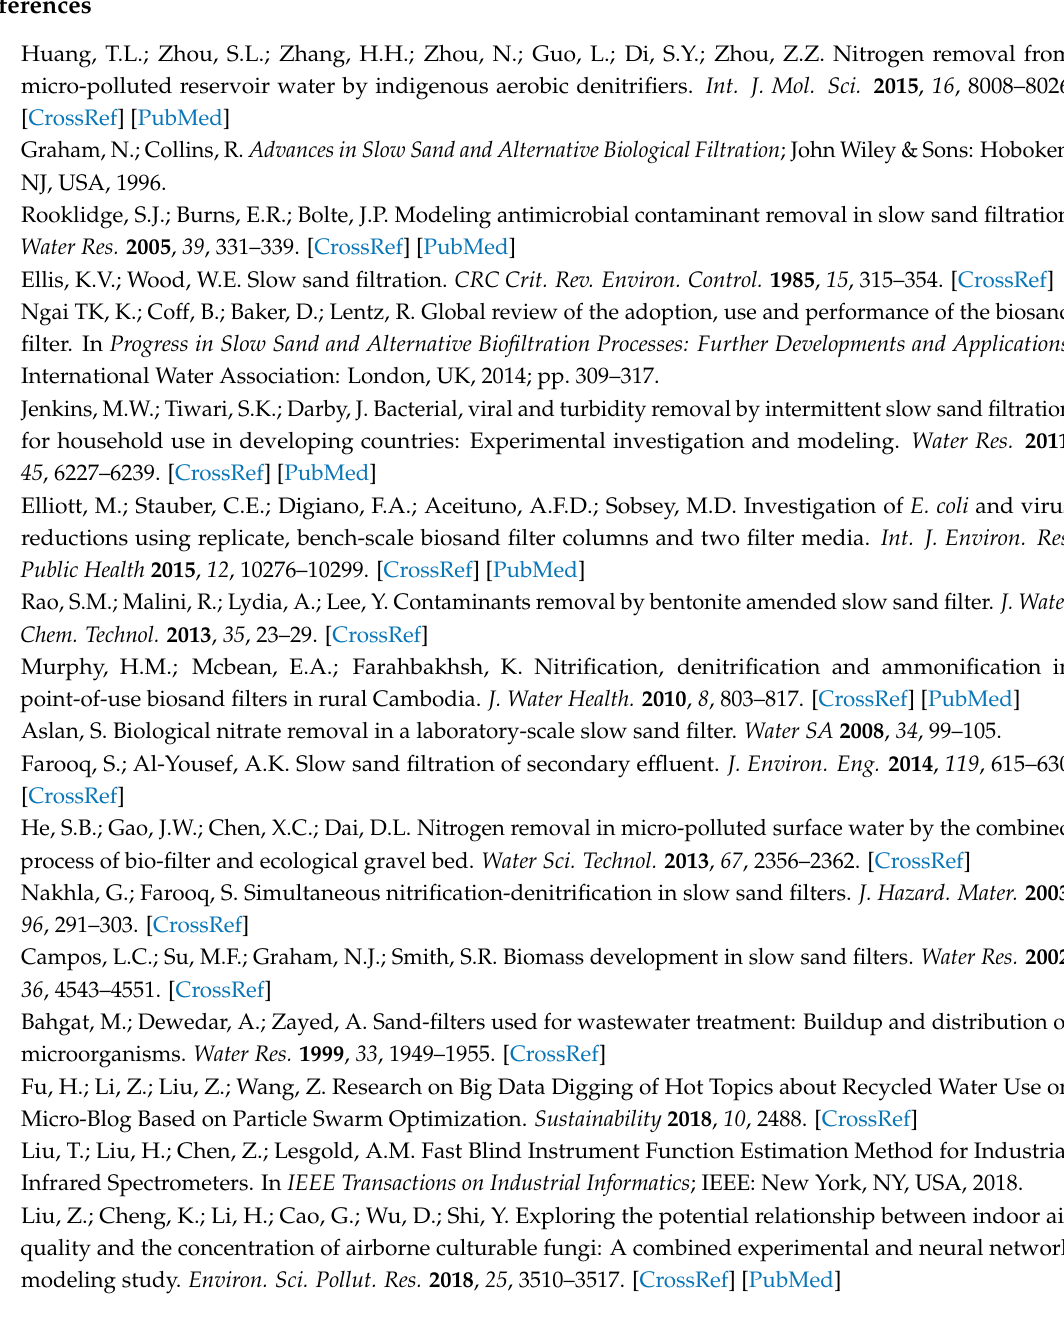
Table S1: Influence of various factors and their interactions on the removal rate of different